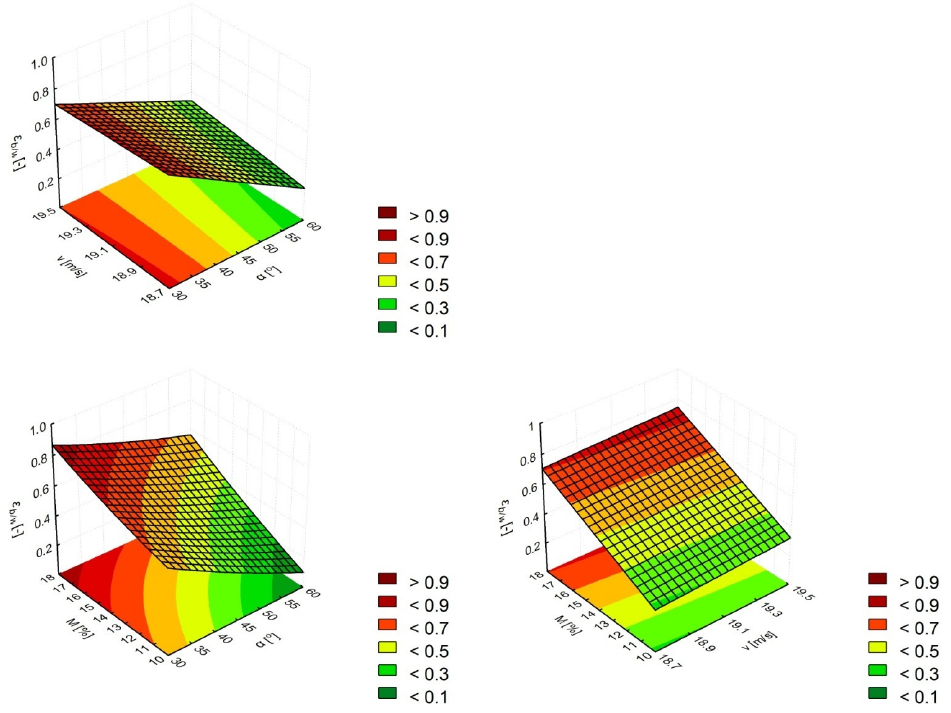
Figure 6. Separation efficiency index of the mixture of buckwheat nutlets and wheat kernels ( ε b / w ) for seeds with different moisture content ( M ), separated at different air stream velocities ( v ), and different cone apex angles ( α ).